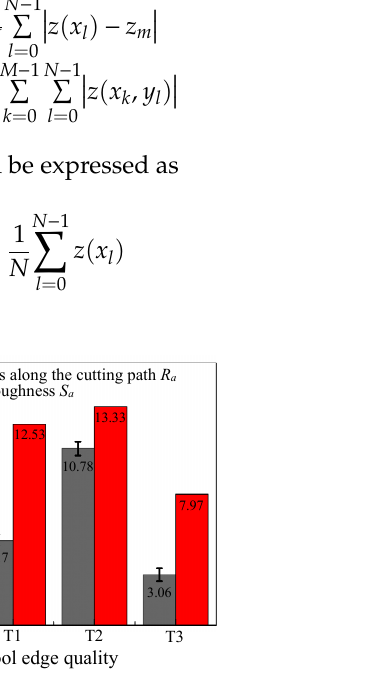
Figure 17. Measured roughness of the machined surface in response to different tool-edge qualities.